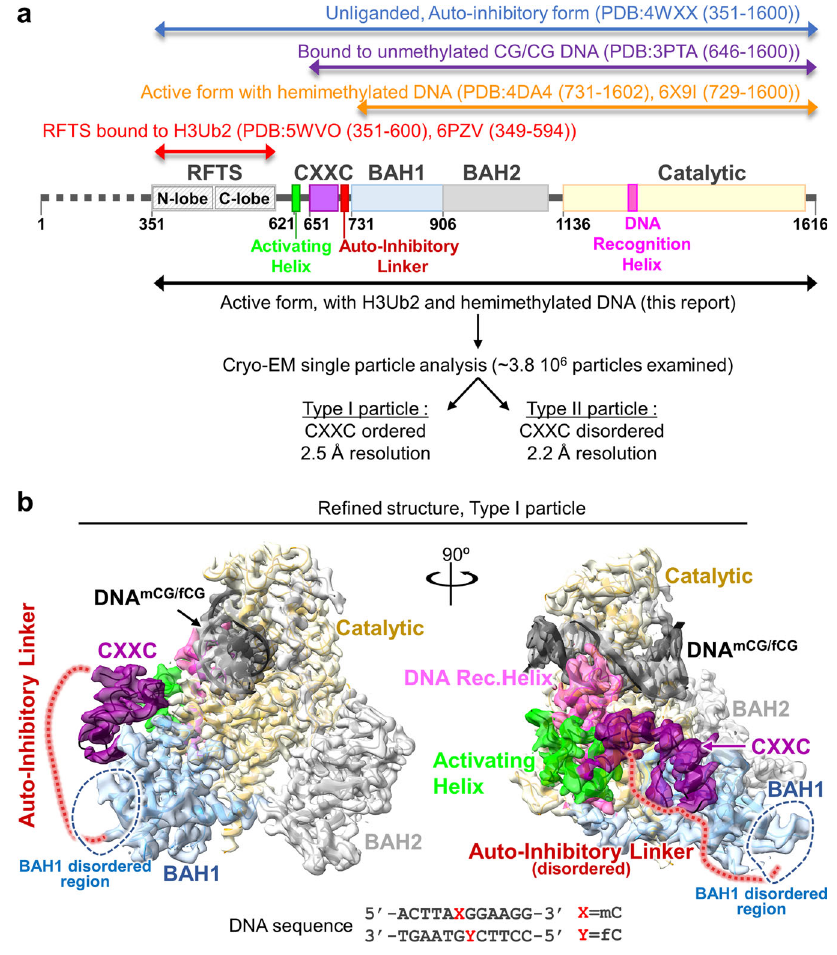
Fig. 1 | Cryo-EM single particle analysis of DNMT1:H3Ub2:DNA mCG/fCG . a Domain architecture of DNMT1, with amino acidnumbersindicated. b Cryo-EM map of the DNMT1:H3Ub2:DNA mCG/fCG ternary complex superposed on the cartoon model.